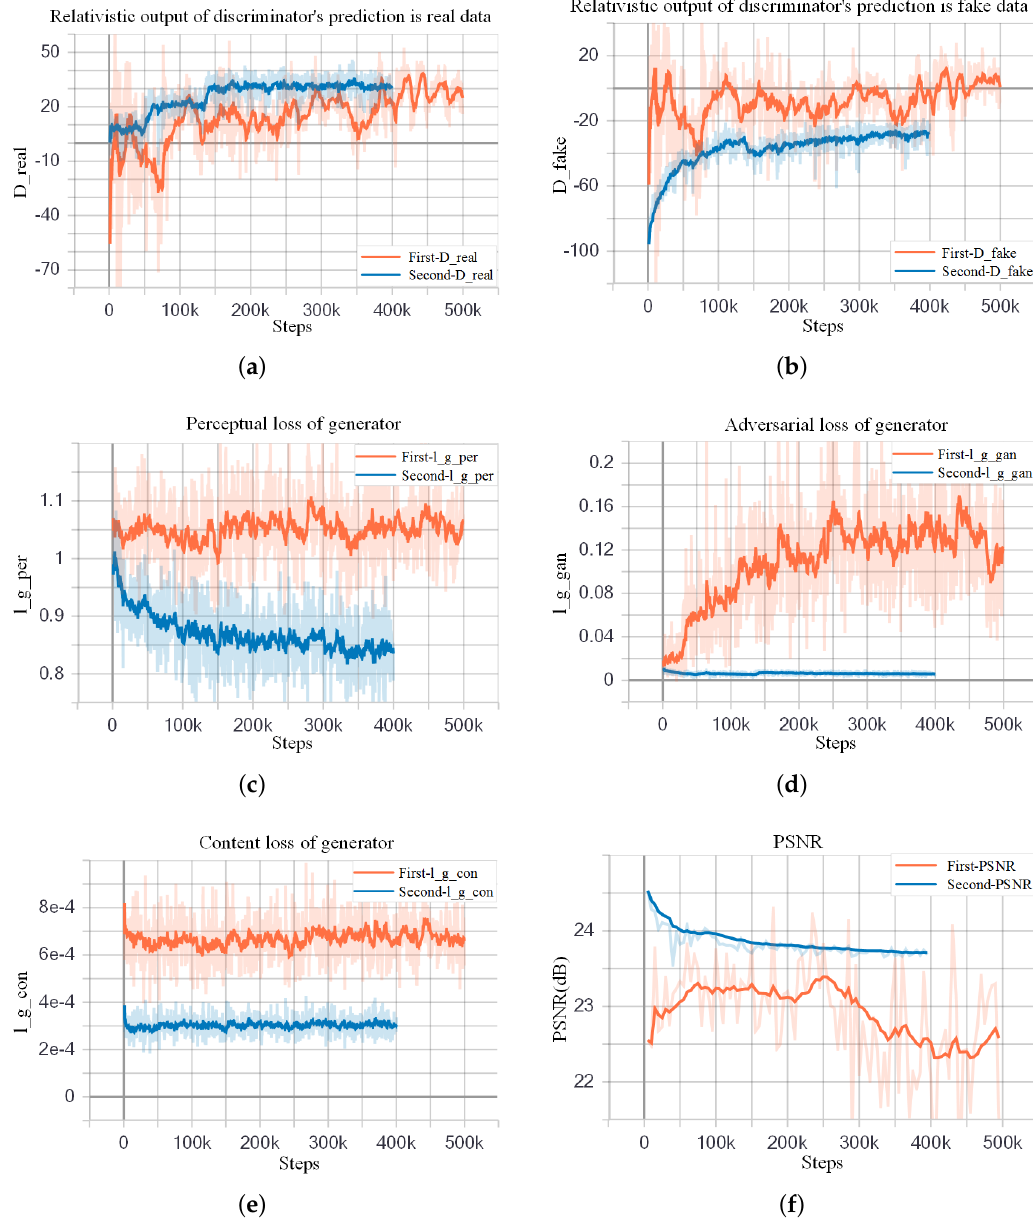
Figure 5. Comparison results of the first and second fine-tune training. In ( a , b ), The blue curves are smoother and have a larger mean absolute value of the difference between D real and D fake than orange ones, which indicates better training of D Ra in second fine-tuning process. The sudden change of the discriminator output at 50 k and 125 k should be caused by the changes in the learning rate. In ( c – e ), blue curves are smoother with smaller absolute losses. In ( f ), compared to the first fine-tuning, the PSNR of the second fine-tuning is higher, which also reflects the good performance of the second